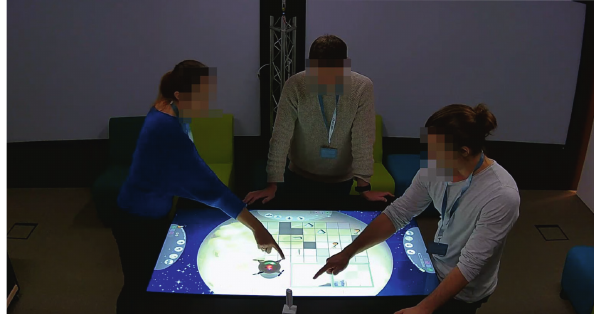
Figure 1: Participants collaboratively solving the problems of the Orbitia